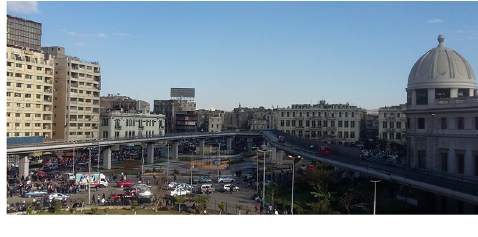
Figure 4. Highlighted corridors mark the original width of alleys before shops extrusions narrowing alleyways